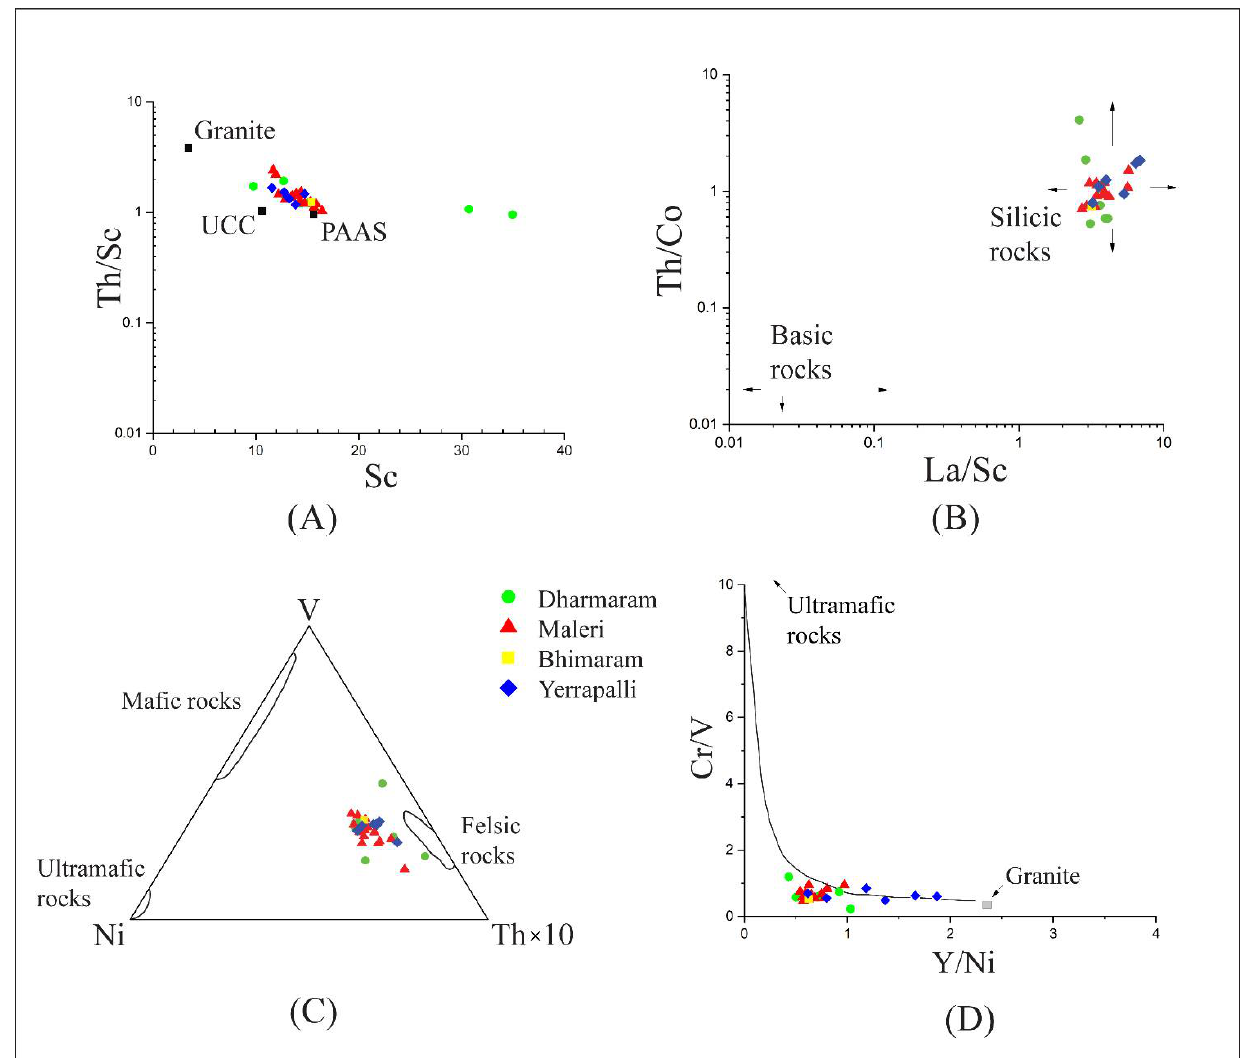
Figure 7. Source rock discrimination based on cross-plots of ( A ) Th/Sc and Sc (adapted from [70]), ( B ) Th/Co and La/Sc ratios [71], ( C ) V-Ni-Th×10 plot [72] and ( D ) Cr/V and Y/Ni (adapted from [73]) for Gondwana mudstone samples.